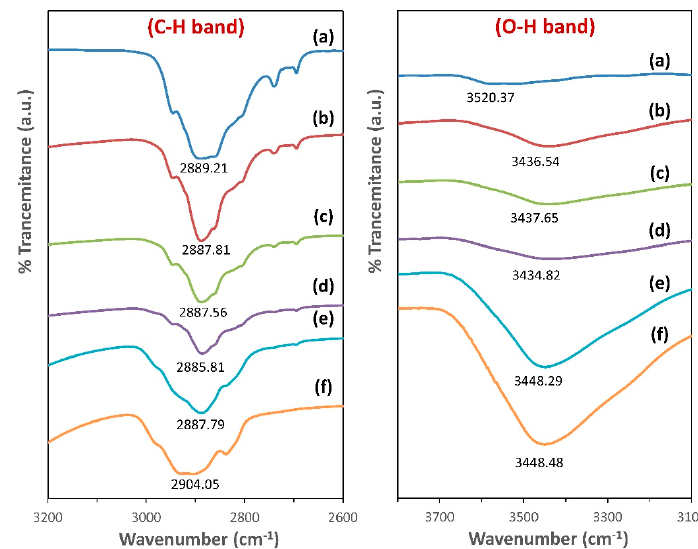
Figure 6. The stretching bond for C–H and O–H bands for: (a) Pure PEO; (b) PEO:MC blend weight ratio 80:20; (c) PEO:MC blend weight ratio 60:40; (d) PEO:MC blend weight ratio 40:60; (e) PEO:MC blend weight ratio 20:80; (f) Pure MC.